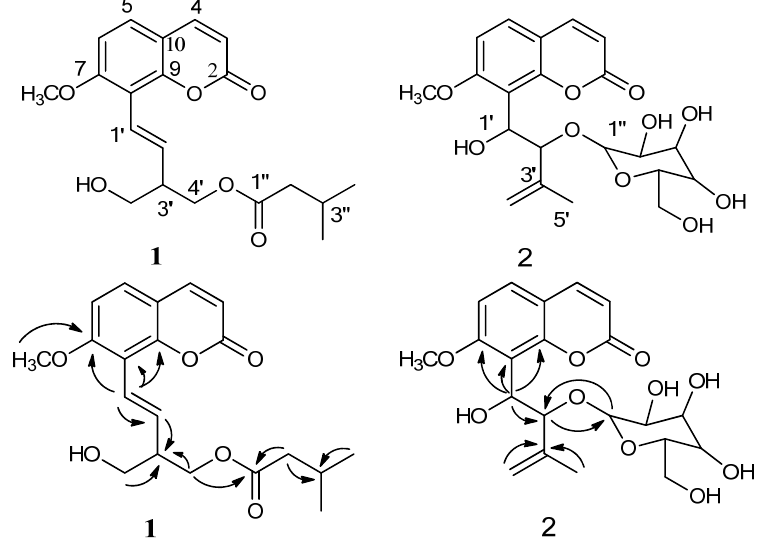
Figure 1. Structures of compounds 1–2 and selected HMBC correlations (H → C) for compounds 1–2